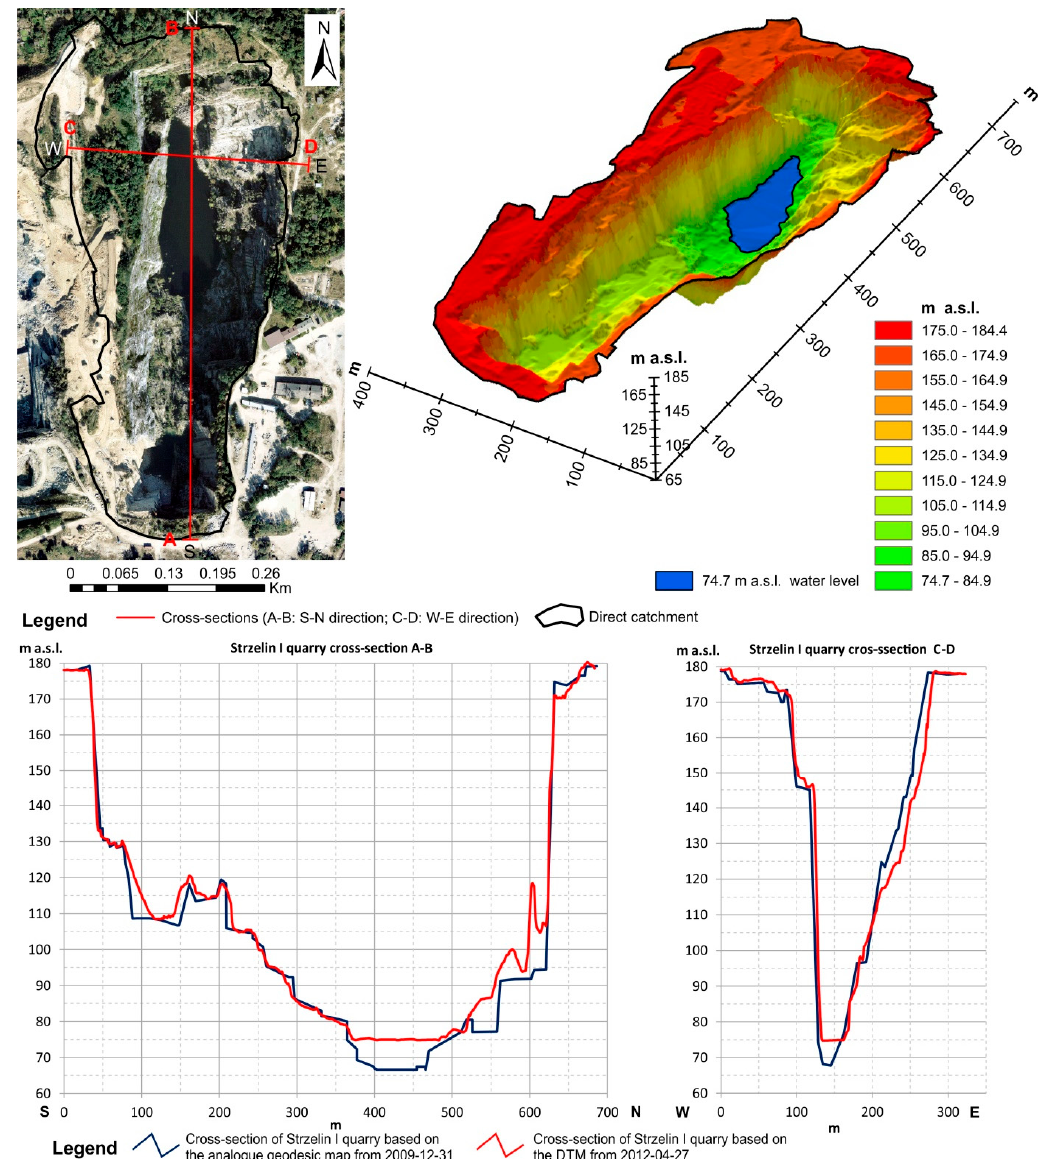
Figure 2. General view of the hypsometric 3D model and cross-sections of the Strzelin I pit .